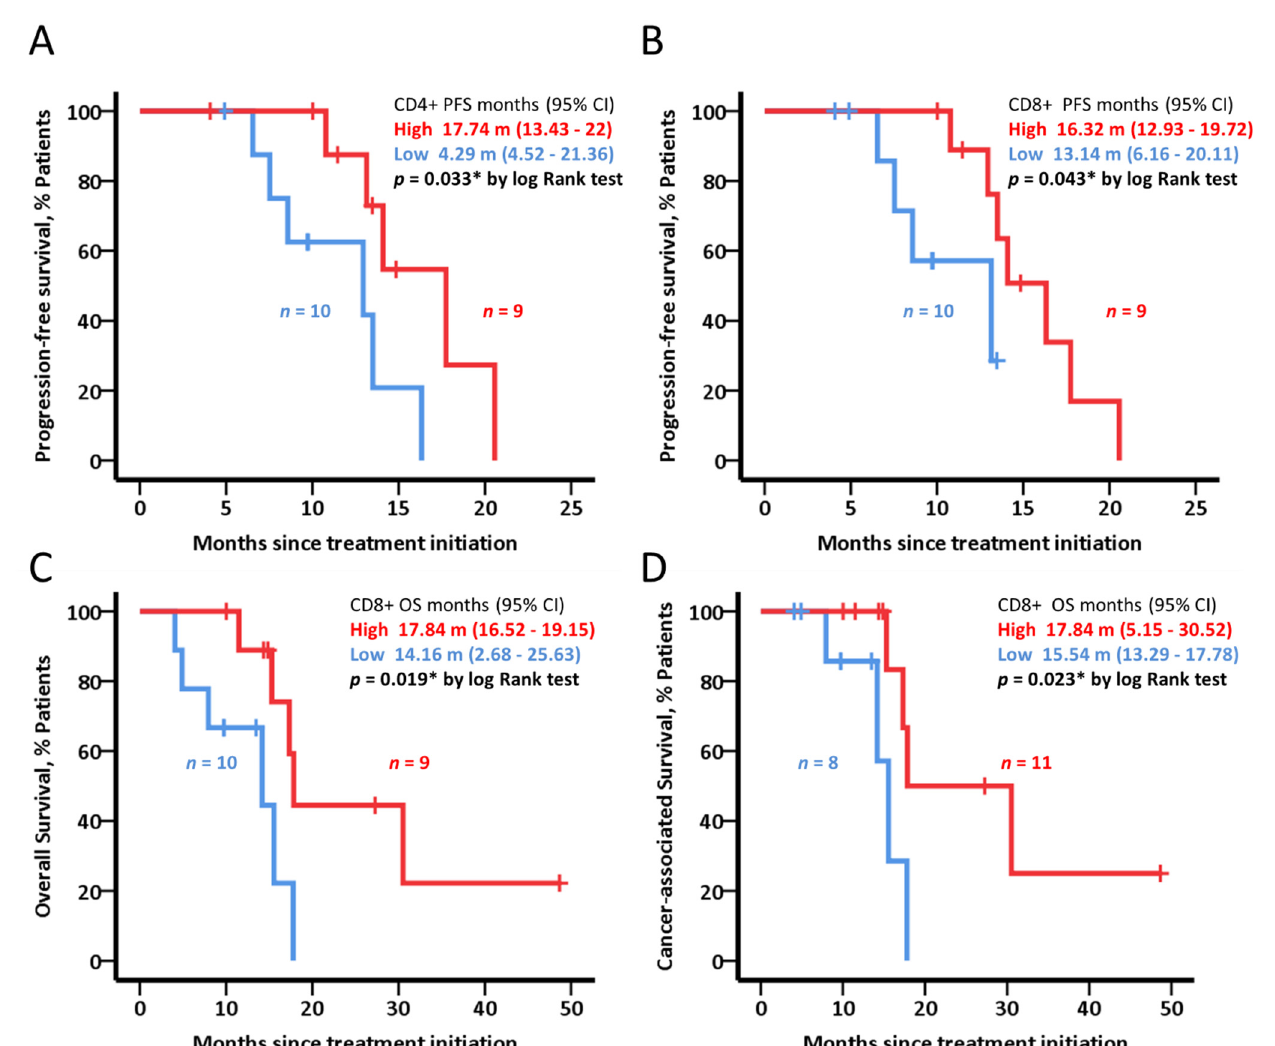
Figure 6. Correlation of CD4 and CD8 T-cell populations in tumor tissue, with clinical outcomes in the BL cohort ( n = 19). ( A , B ) Kaplan–Meier plots for PFS, ( C ) for OS, and ( D ) for cancer-associated death. * in the figures indicate significant ( p <